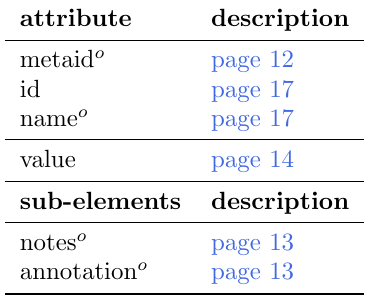
Table 2.3: Attributes and nested el- ements for parameter. o denotes op- tional elements and